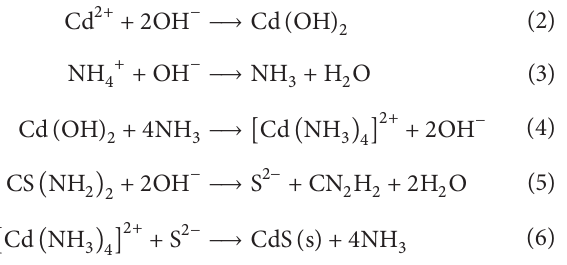
evaporated for 24 h and the viscous solution turned into solid MWCNT/PSF films. Five samples were obtained from each batch. The direct current (DC) electrical